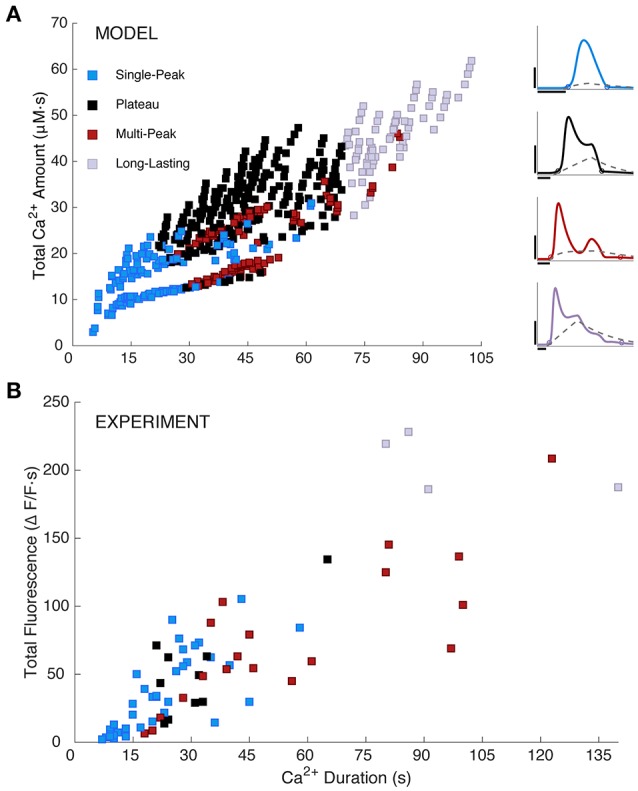
Simulated and measured Ca2+ responses. (A) Simulated total Ca2+ amount (the area under the [Ca2+]cyt curve) vs. Ca2+ duration as defined in section Materials and Methods. Model responses were generated by choosing IP3 parameter sets as specified in section Materials and Methods and Table 1. Response types are indicated as shown. The right panel repeats example Ca2+ traces from Figure 2A, column 3 with their respective IP3 time courses added. The IP3 parameters are as follows (in order, A, drise, rrise, ddec): 0.2, 10, 0.2, 90 (SP); 0.375, 34, 0.002, 110 (PL); 0.26, 41, 0.15, 200 (MP); 0.6, 39, 0.002, 220 (LL). Horizontal scale bars, 10 s; vertical scale bars, 0.5 μM. (B) Experimentally measured Ca2+ responses (y-axis shows area under the ΔF/F trace; N = 19 somas and 52 large processes from a total of 3 mice, 3–6 trials per mouse, 2–5 cells per trial; 16–250 ms stimulus durations) are similar to modeled responses, but more sparsely and non-uniformly distributed. One outlier point was omitted from (B), at a duration and total fluorescence of about 363.